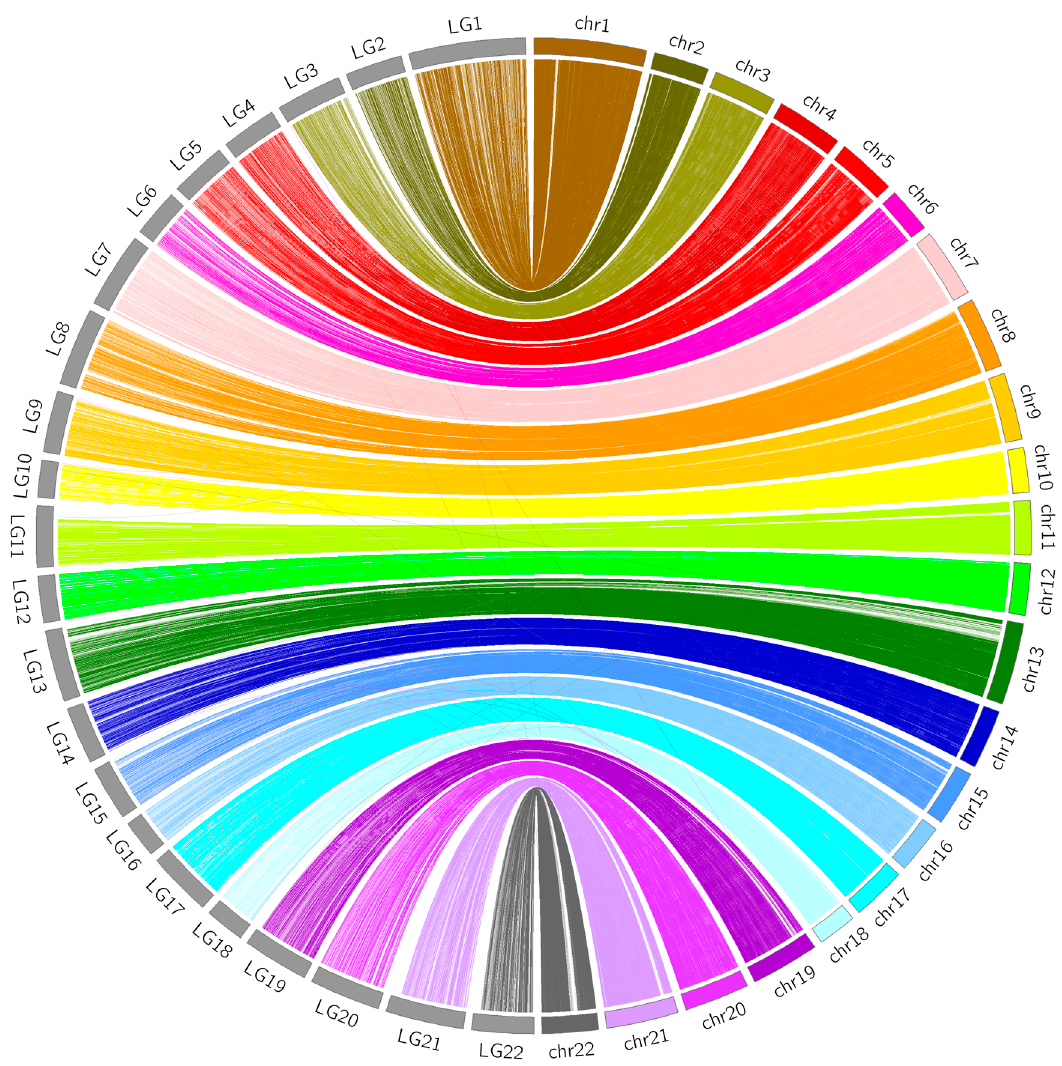
Figure 5. Comparison between the present genetic linkage map and FUGU5. Links connect the genetic and physical locations of each mapped SSG. Grey blocks on the left represent the 22 linkage groups of the present linkage map, whereas colorful blocks on the right represent the 22 chromosomes of FUGU5. LG: linkage group; chr: chromosome.